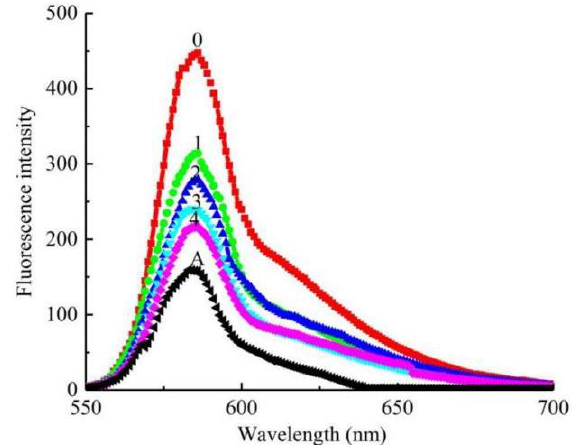
Figure 5. Fluorescence emission spectra of tyrosine solution in presence of Q1 with different con- centrations. Concentrations of samples for curves 0 – 4 are 0, 9, 18, 27, 36 μM. Curve A is fluorescence emission spectra of Q1 at concentration of 36 μM. trations. Concentrations of samples for curves 0–4 are 0, 9, 18, 27, 36 µ M. Curve A is fluorescence emission spectra of Q1 at concentration of 36 µ